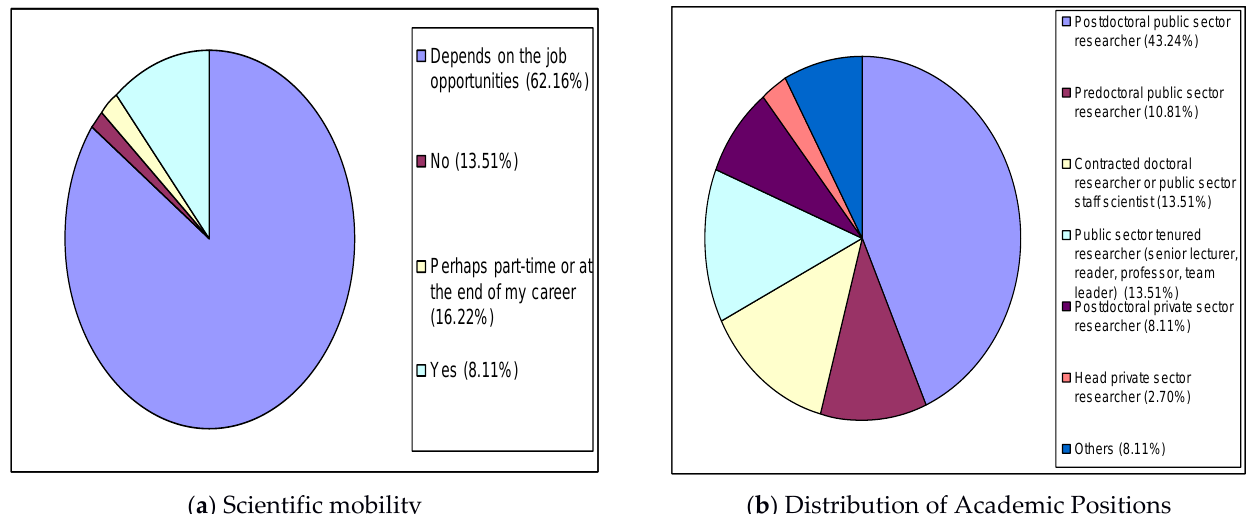
Figure 2. Profile of health sciences spanish scientists abroad. ( a ) Scientific mobility. ( b ) Distribution of Academic Positions.